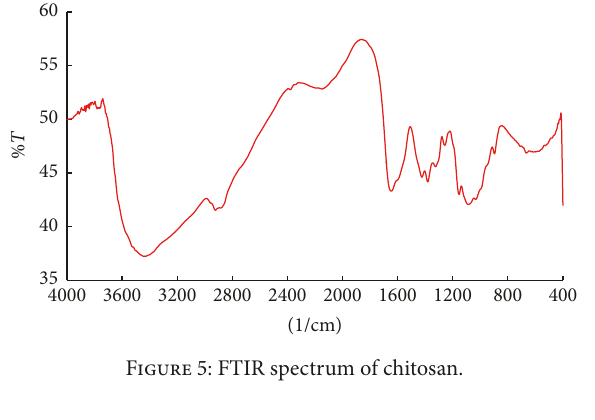
Figure 5: FTIR spectrum of chitosan.